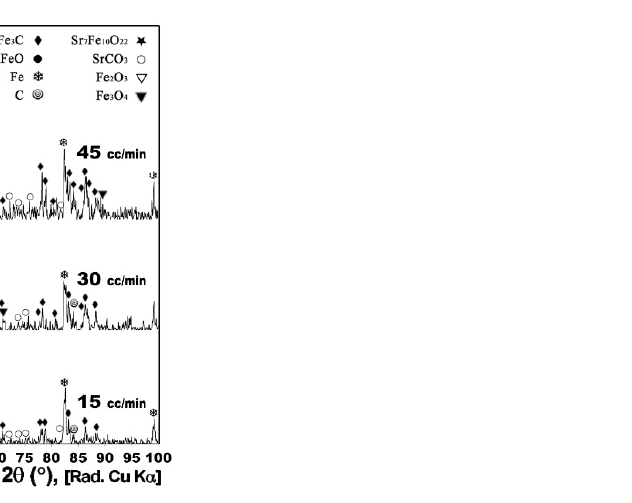
Figure 2. XRD patterns of conventionally synthesized Sr ‐ hexaferrite powders heat treated under dynamic CH 4 flow of 15, 30 and 45 cc/min at 950 °C for 1 h.